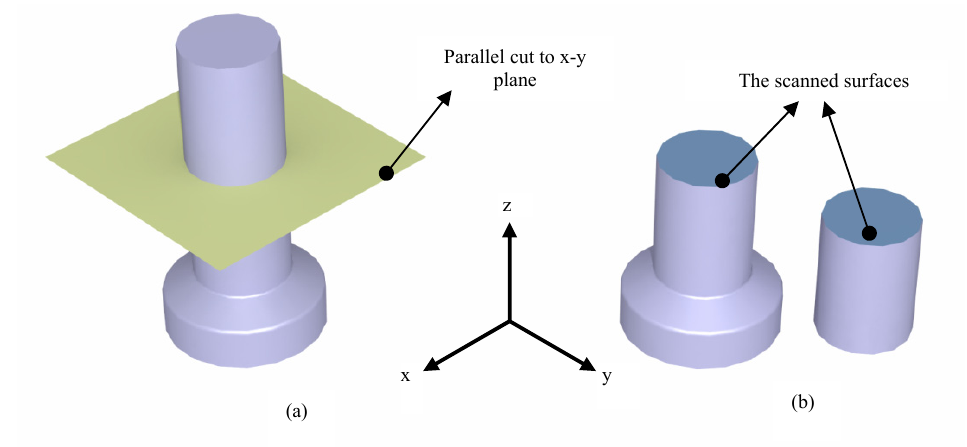
Figure 2. (a) Specimen and the cutting plane (b) Contour measured surfaces